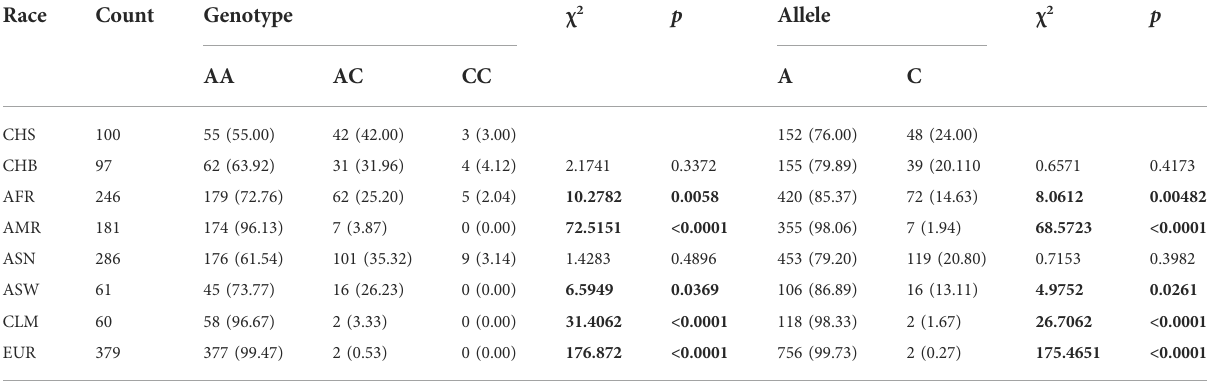
TABLE 1 Sepsis patients have higher lnc-ZNF33B-2:1 level (from the GEO database).